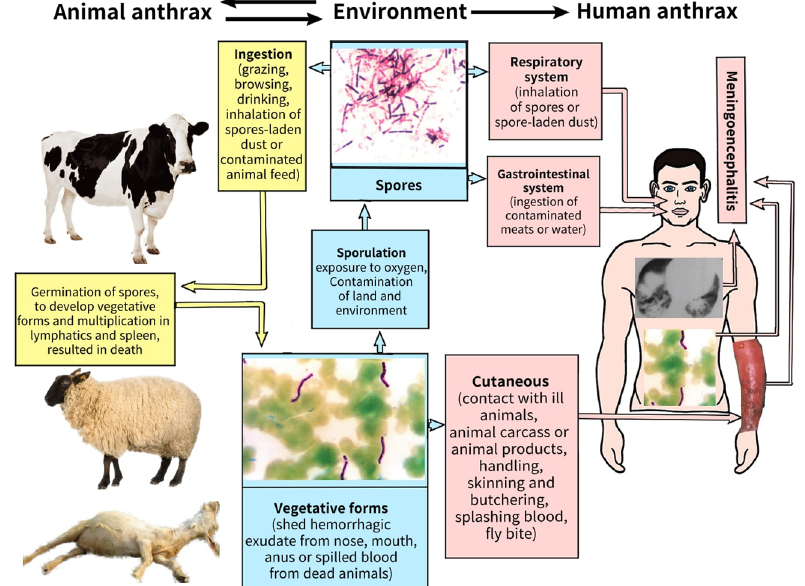
Figure 1. The life cycle of Bacillus anthracis in nature. Soil is the main reservoir of the pathogen and is contaminated by spores released from the carcasses of infected animals. Animals grazing on spore-contaminated land become infected resulting in a new cycle of infection, death and release of spores which can potentially contaminate a new location. Wild carnivores and scavenger birds and flies may also contribute to the spread of spores. Humans can be infected by contact with infected animals or contaminated animal products. The figure was created by Fatma Beyzanur Koyuncu, Medical student in Lokman Hekim University, Ankara).